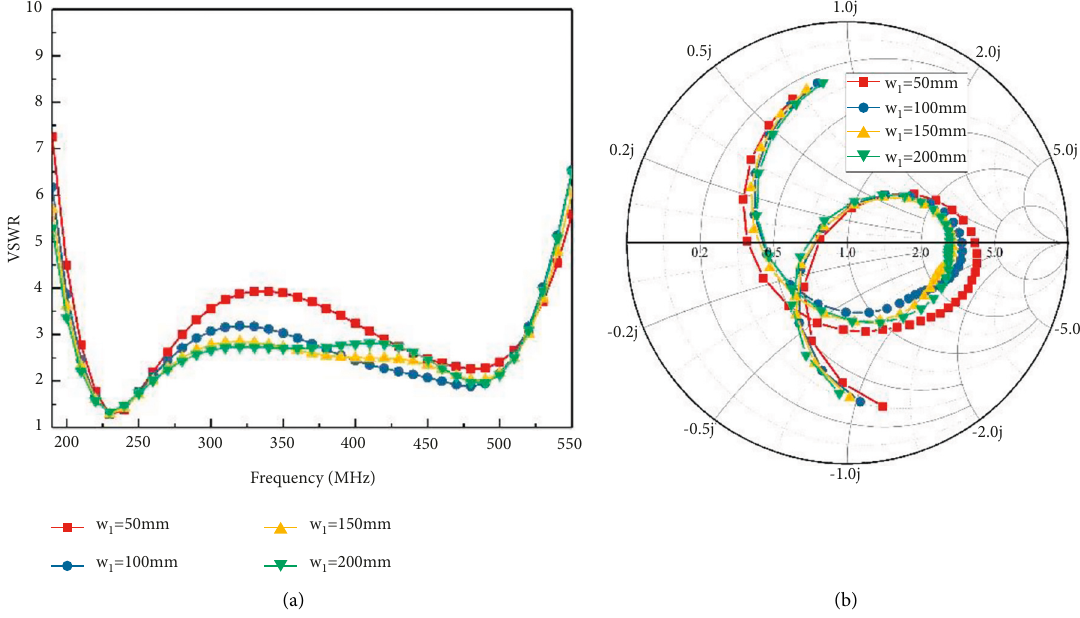
Figure 15: (a) VSWR curves and (b) Smith charts with different values of w